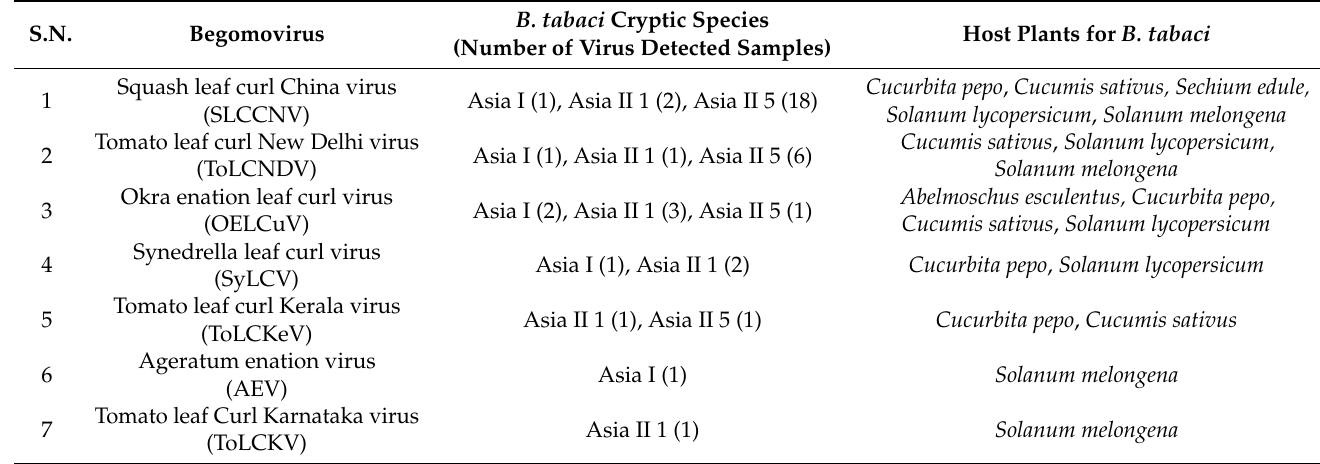
Table 2. List of the begomoviruses detected from the three cryptic species of Bemisia tabaci collected from various host plants in Nepal.